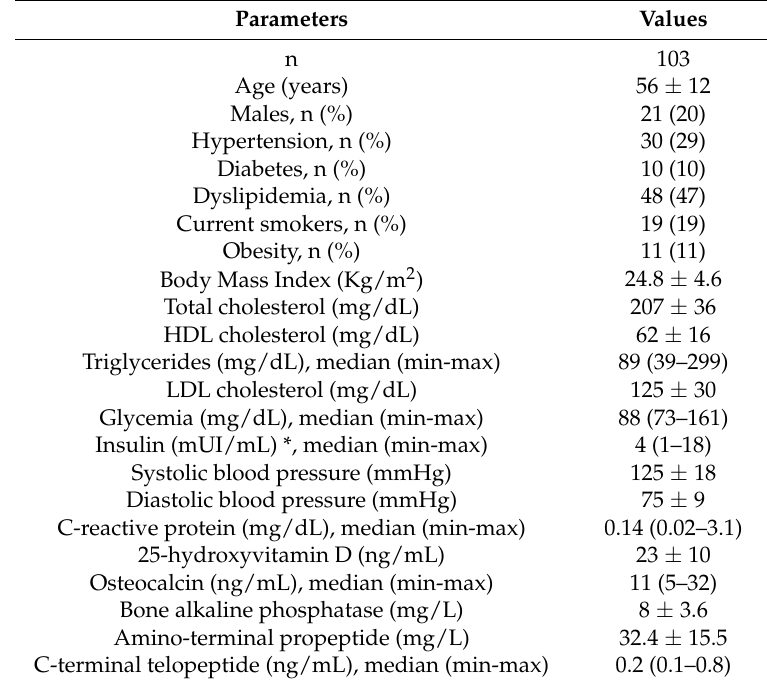
Table 1. Demographic, clinical and biochemical characteristics of the studied